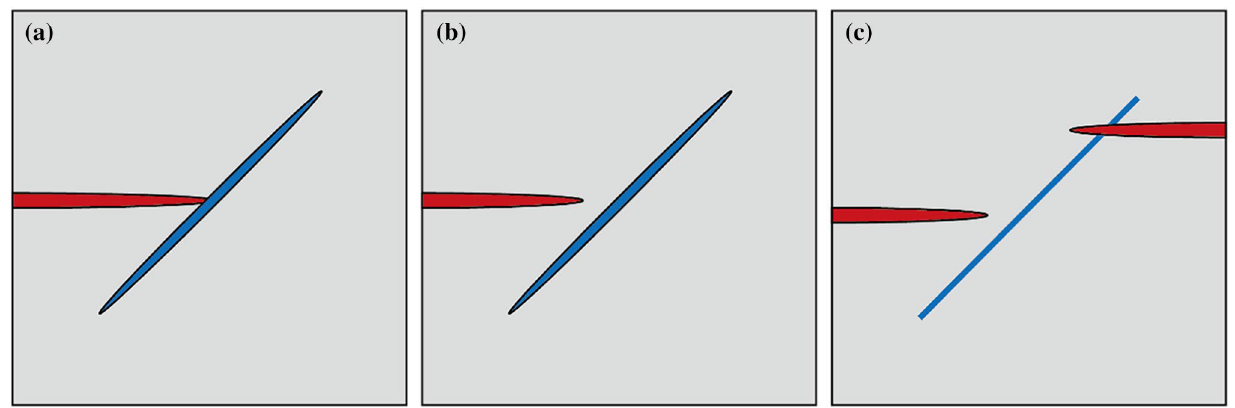
Fig. 8 Three types of natural fractures after hydraulic fracturing. Red parts represent main fractures, while blue is natural fractures. Sub- figure ( a ) means natural fractures connected with main fracture and branch fractures formed (blue); Subfigure ( b ) means natural fractures